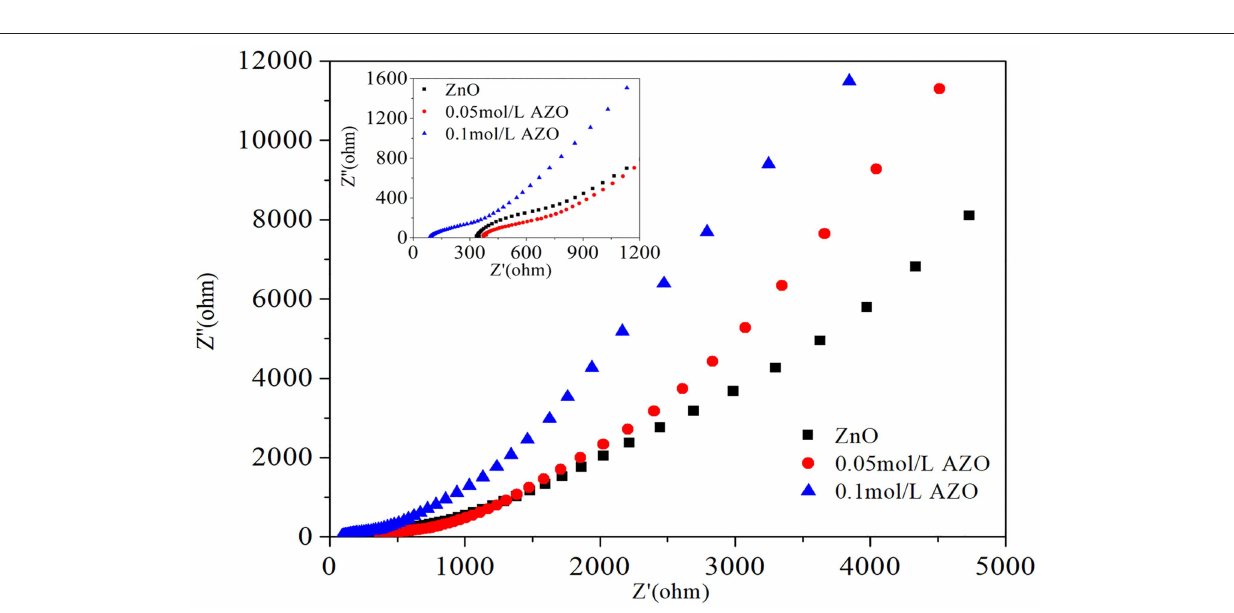
Frontiers in Materials |